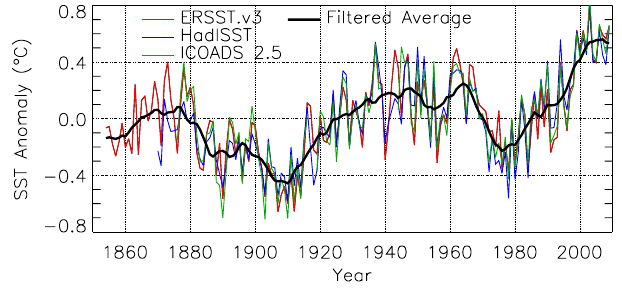
Fig. 17. Mediterranean annual SST anomaly (with respect to the 1971–2000 average) from 1854 to 2008. The red line shows ERSST.v3, the blue line HadISST, and the green line ICOADS 2.5. The solid black line represents the filtered average of the three data sets (from Marullo et al., 2011, American Meteorological Society; used with